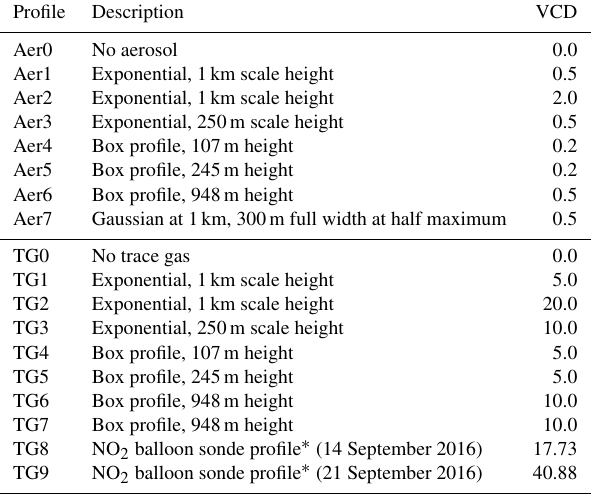
Table 2. Characterisation of the aerosol and trace gas profiles de- picted in Fig. 2. Aerosol VCDs are in units of 10 8 µm 2 cm − 2 , while trace gas VCDs have units of 10 15 moleccm − 2 .